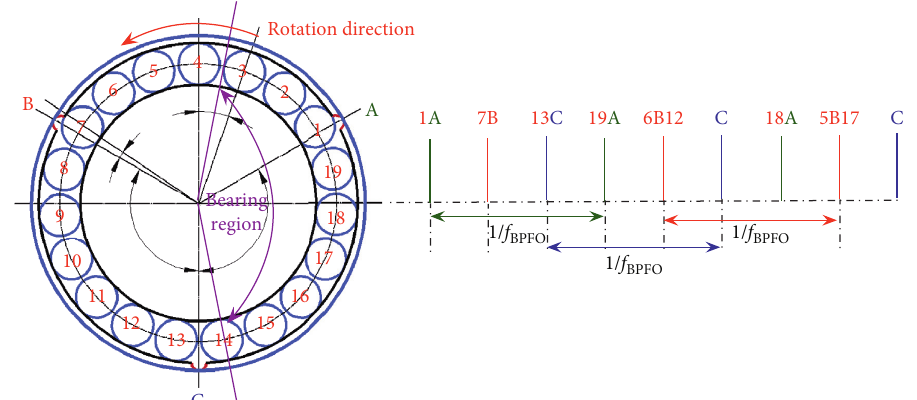
Figure 21: Dynamic action relationship between outer race faults and rollers.